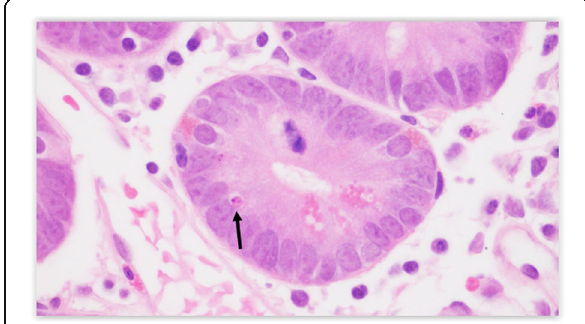
chromatin and eosinophilia